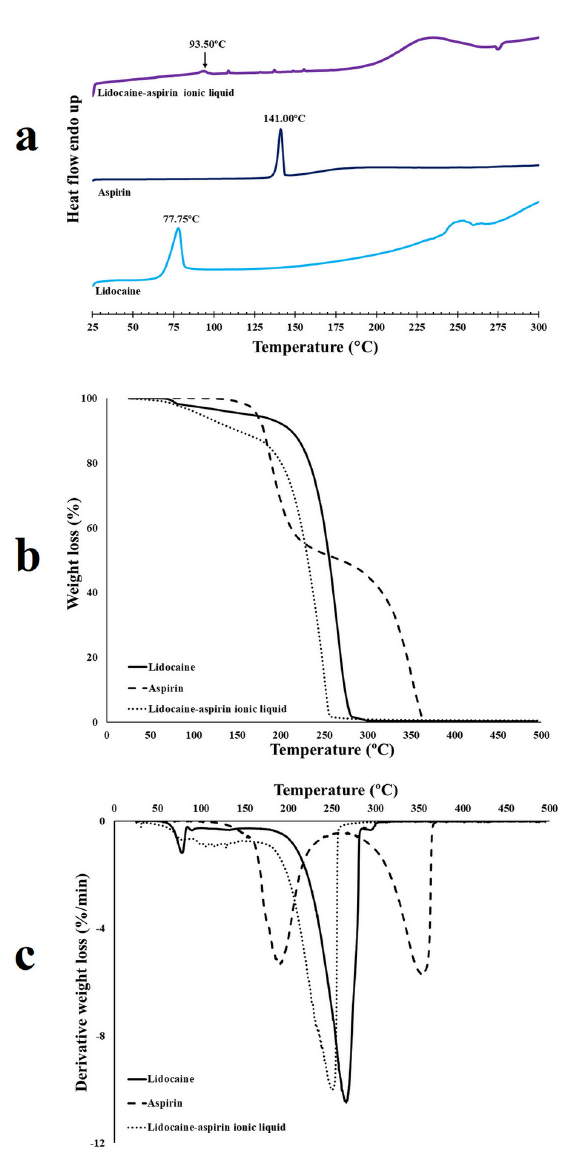
Figure 2. Characterization of the lidocaine/aspirin ionic liquid: (a) DSC thermogram, (b) TGA thermogram, and (c) DTG